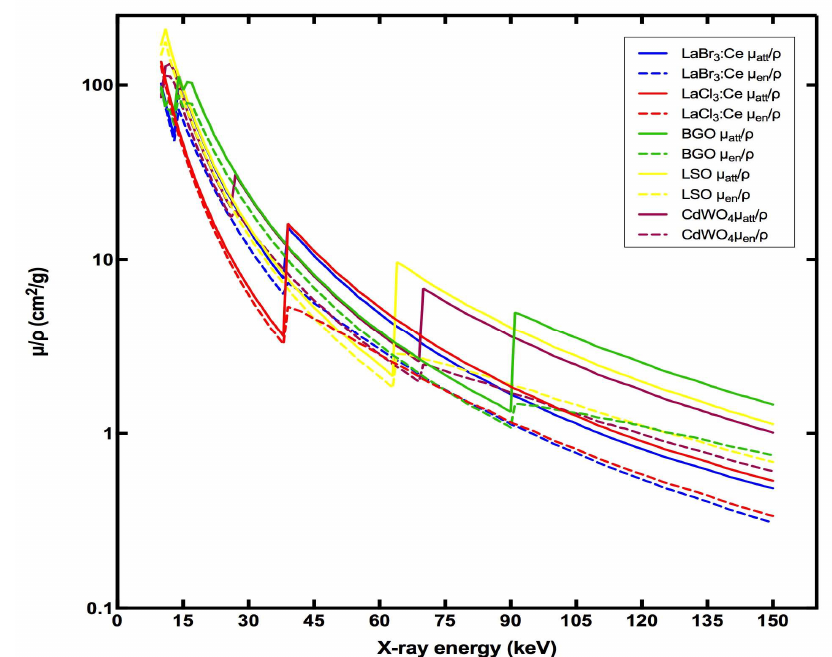
Figure 3. Attenuation coefficients of the LaBr 3 :Ce, LaCl 3 :Ce, BGO, LSO and CdWO 4 single crystals.